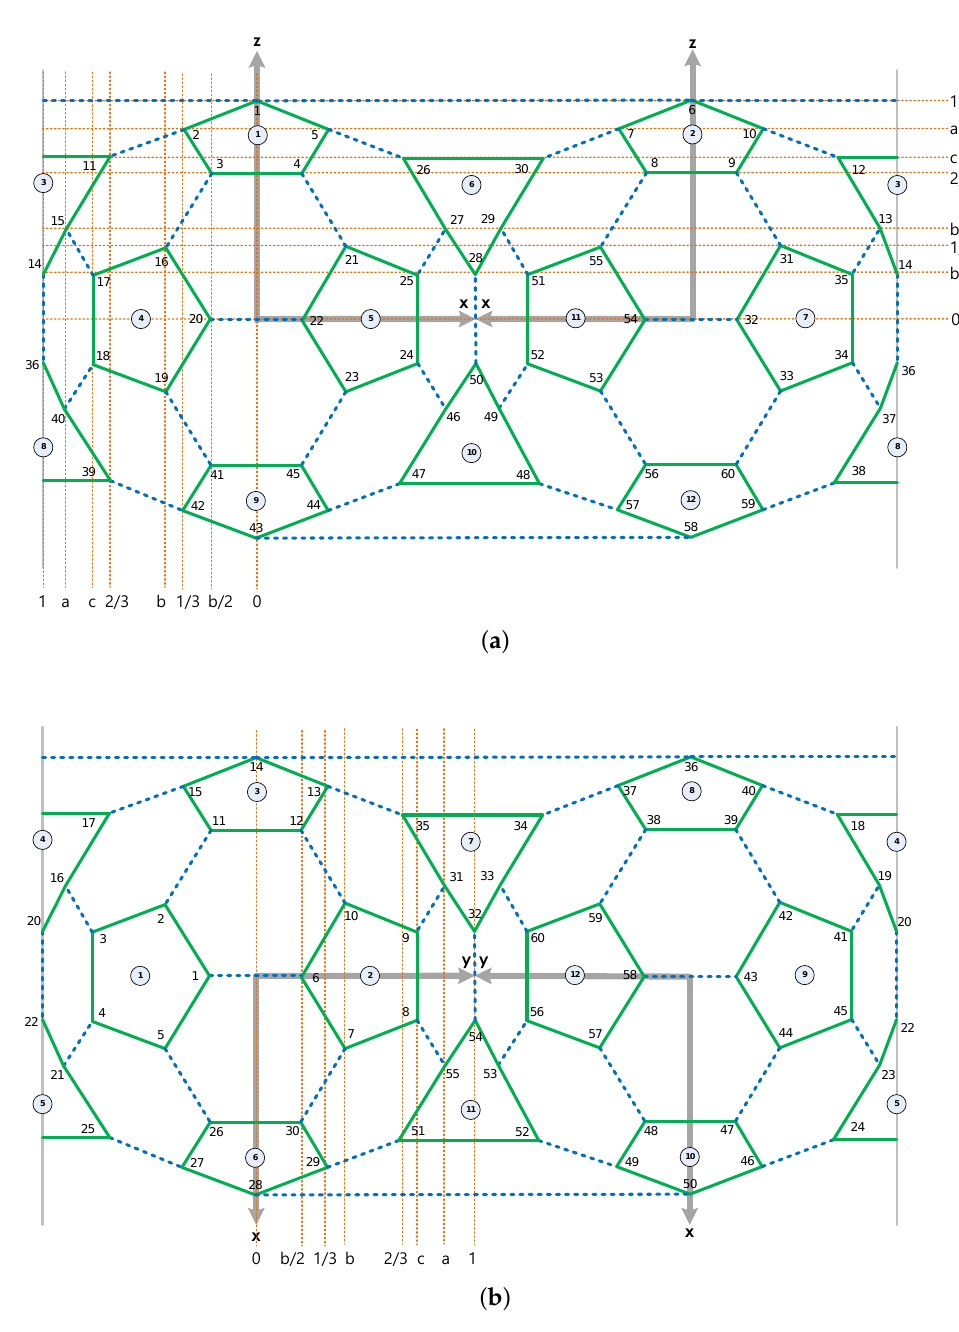
Figure 23. Rectangular coordinates of the 3D-truncated icosahedron tensegrity in a 2 × 2 × 2 cube, √ √ √ where a = ( 3 + 5 ) /6, b = ( 5 − 1 ) /3, and c = 5/3. ( a ) Front view. ( b ) Top view. Table 7. Cartesian coordinates of the 3D-truncated icosahedron tensegrity using the connectivity √ √ shown in Figure 17, where a = ( 3 + 5 ) /6, b = ( 5 − 1 ) /3, and c =